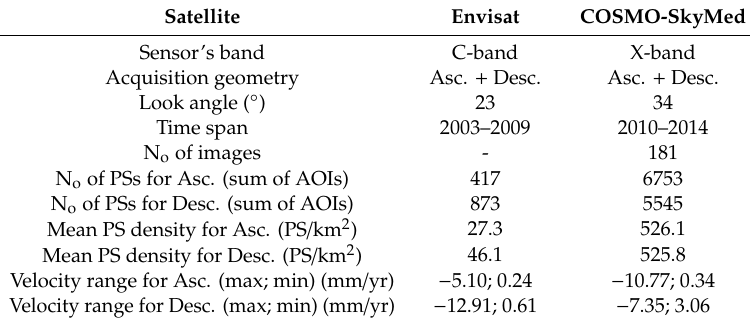
Table 1. SAR data used in this work and general processing results.